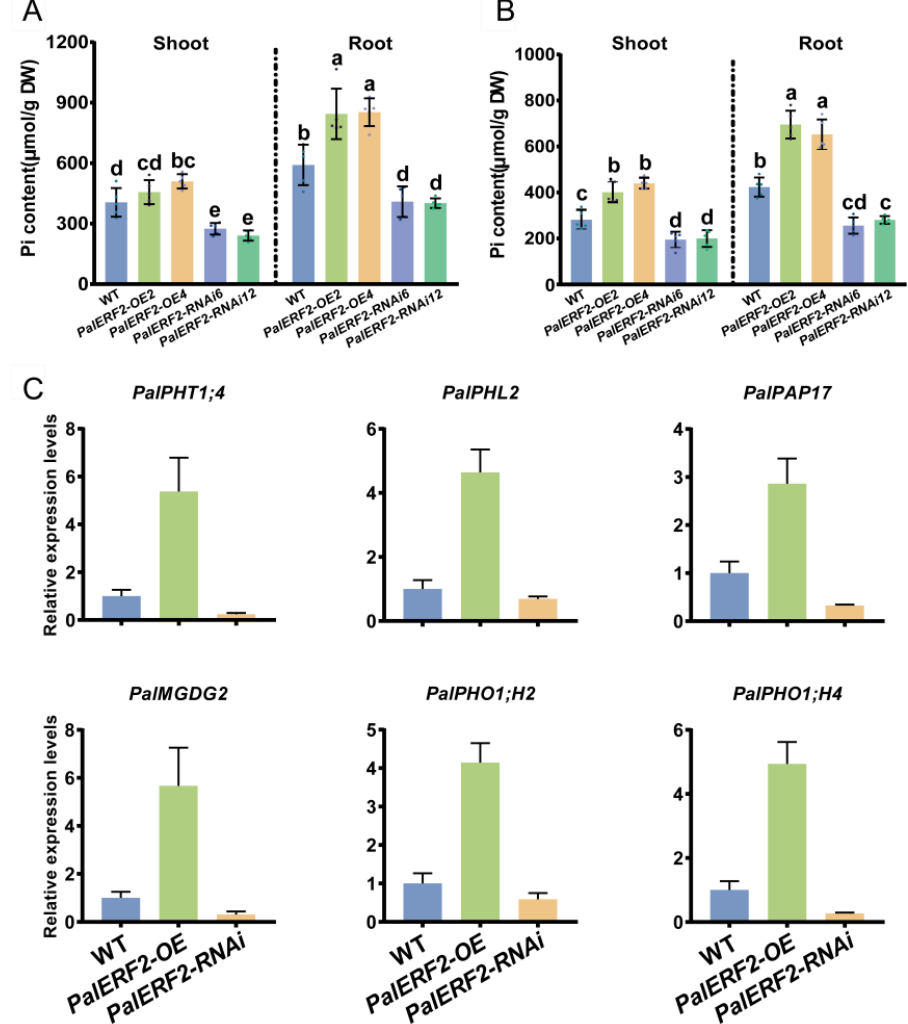
Figure 6. The Pi contents and the expression of PSR genes in PalERF2 transgenic and WT poplars. ( A ) The Pi contents in WT and transgenic plants before drought treatment. ( B ) The Pi contents in WT and transgenic poplars after drought treatment. ( A , B ) Error bars indicate SD values from three biological replicates. Significant difference was analyzed by Duncan’s test ( p < 0.05, n = 5). Different letters indicate statistically significant differences. ( C ) The qRT-PCR analyzed the relative expression of PSR genes in WT and transgenic poplars after drought treatment. Error bars indicate SD values from three biological replicates.